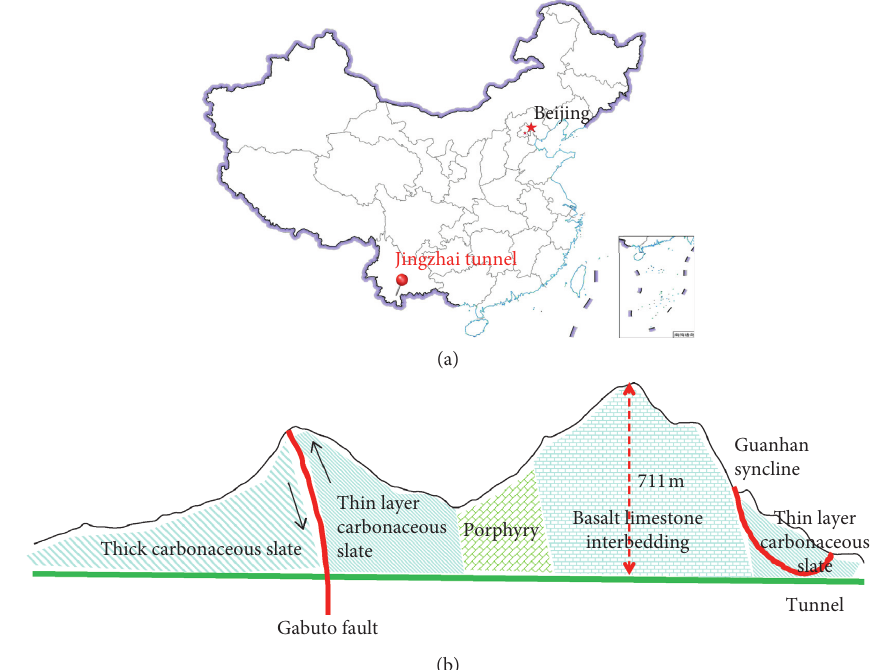
Figure 1: Study area and geological structure. (a) Research target location. (b) Geological structure.